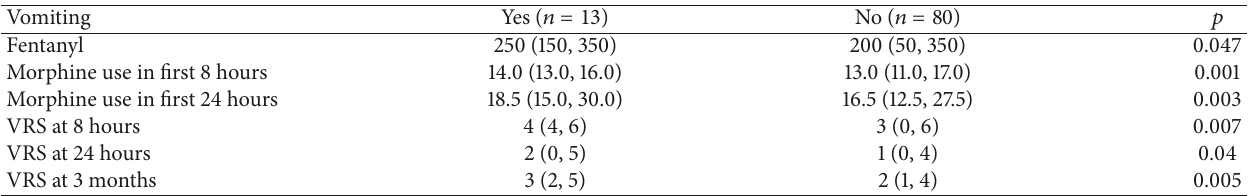
Table 4: Fentanyl and morphine consumption and pain scores in patients who did versus patients who did not vomit. Data are presented as median (Min, Max). Groups were compared using the Mann–Whitney